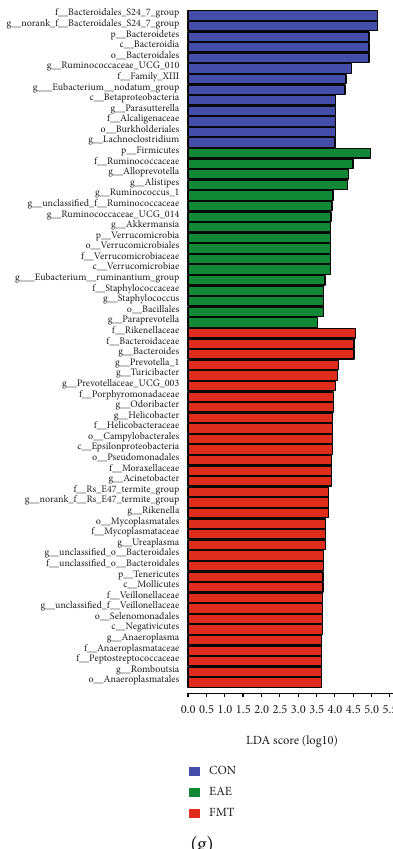
Figure 1: FMT modulates GM in EAE. (a) Chart of the Shannon index values for evaluation of GM α -diversity. The Shannon index for GM was signi fi cantly increased in EAE mice ( n = 6 ) compared to normal controls (CON, n = 5 ); an in-between value was found in FMT-treated immunized mice (FMT; n = 6 ) without statistical signi fi cance. (b) Chart of relative abundance of gut bacterial taxa (phylum level) performed with the Mann – Whitney U test, corrected by FDR between the two groups. The fi gure was created by used un fi ltered OUT table. (c) PCoA plot (PC1/PC2) of unweighted UniFrac distances illustrating clustering separation between samples from di ff erent mouse groups. (d) Hierarchical clustering tree on OTU level (weighted UniFrac). (e) The correlation heatmap chart performed with a Spearman ’ s correlation of bacterial abundance with EAE scores and cumulative scores. The R value is shown in di ff erent colors in the fi gure. The legend on the right is the color interval of di ff erent R values ( ∗ 0 : 01 < p < 0 : 05 and ∗∗ 0 : 001 < p < 0 : 01 ). (f) LEfSe cladogram showing di ff erentially abundant gut bacterial taxa. The diameter of each dot is proportional to its e ff ect size. Each ring (from inside to outside) represents a taxonomic level from kingdom to genus, the cladogram was made on fi ltered data, and only taxa with greater than 0.1% relative abundance. (g) LDA scores of abundant gut bacterial taxa (LDA score threshold > 2.0). k: kingdom; p: phylum; c: class; o: order; f: